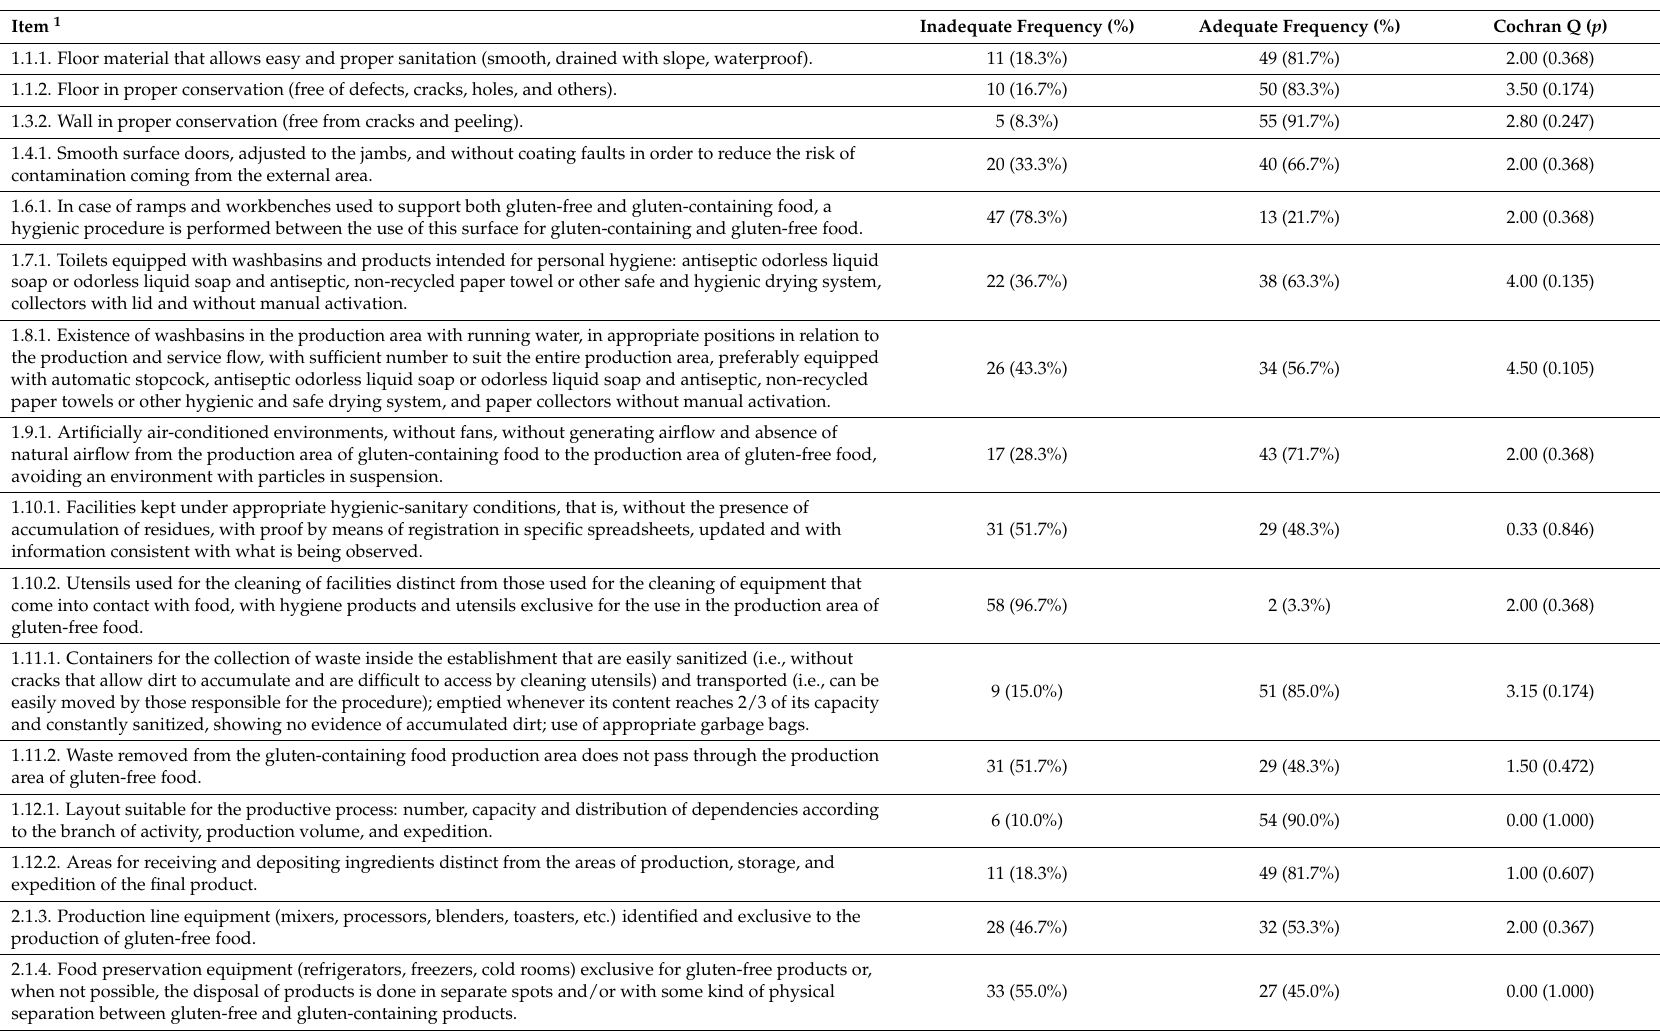
Table 2. Items of the final version of the check-list and frequencies of responses observed in the food